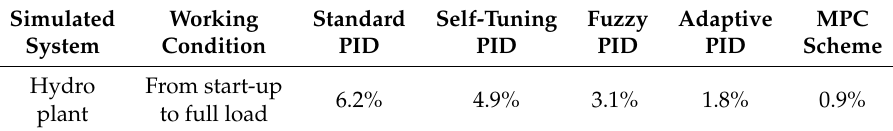
Table 2. Performance of the considered control solutions for the hydroelectric plant. Simulated